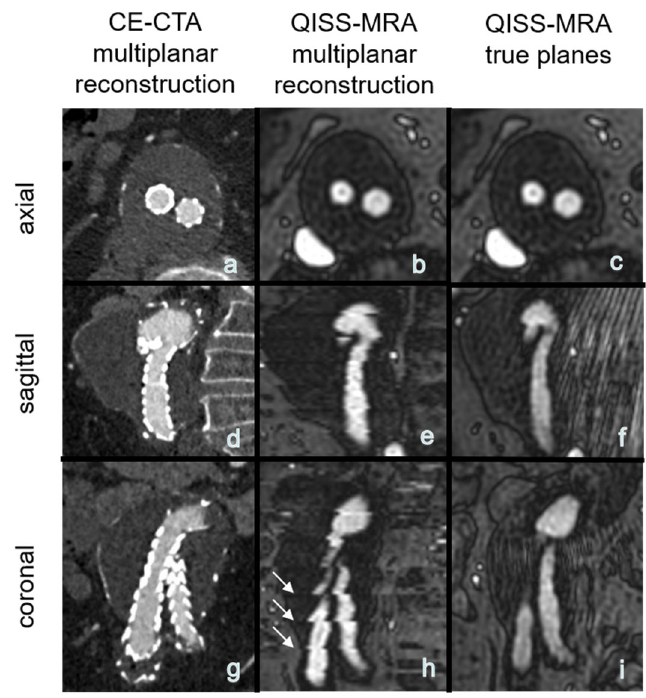
Figure 5. ( a – h ): Exemplary multiplanar CE-CTA and 2D non-CE radial QISS-MRA-images of an aneurysm. Note that the horizontal hyperintense lines are due to missing data for a 3D reconstruction, impairing aneurysm size measurements in coronal and sagittal QISS-MRA images (white arrows, image ( h )) compared to the true (measured) sagittal and coronal planes ( f , i